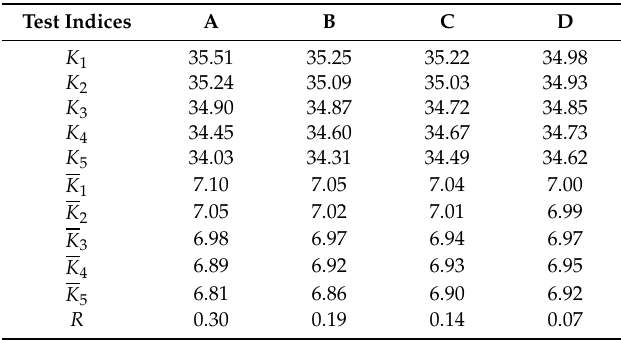
Table 6. Range analysis of H